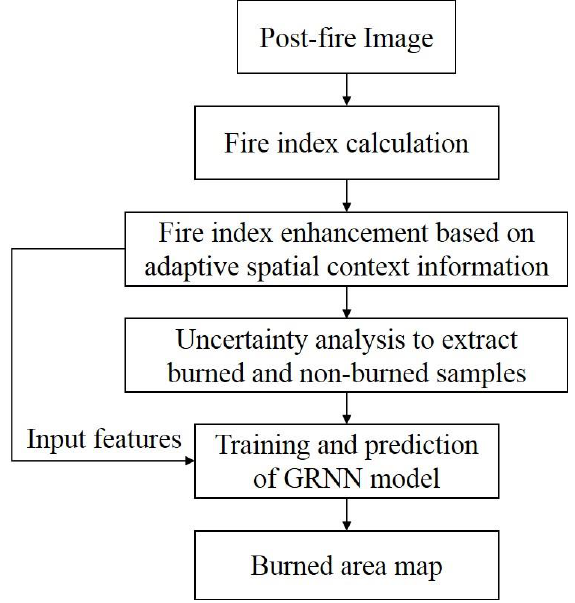
Figure 1. The flow chart of the proposed burned area mapping